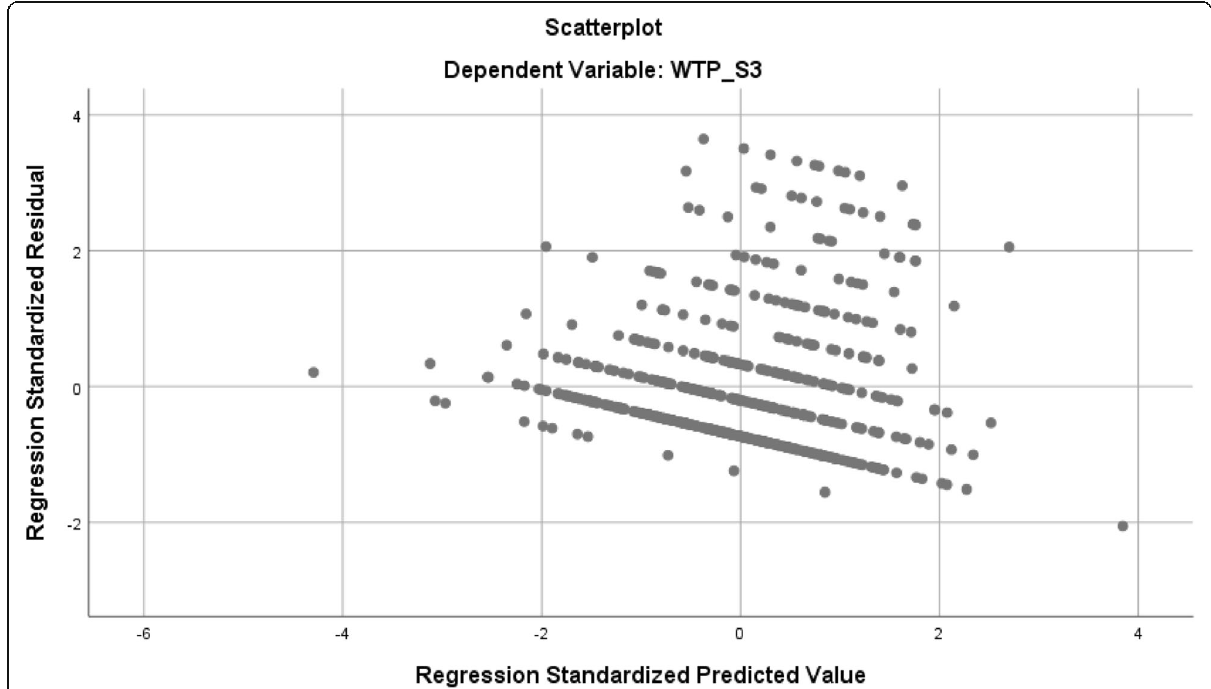
Fig. 15 Scatterplot of residuals versus predicted values of Model